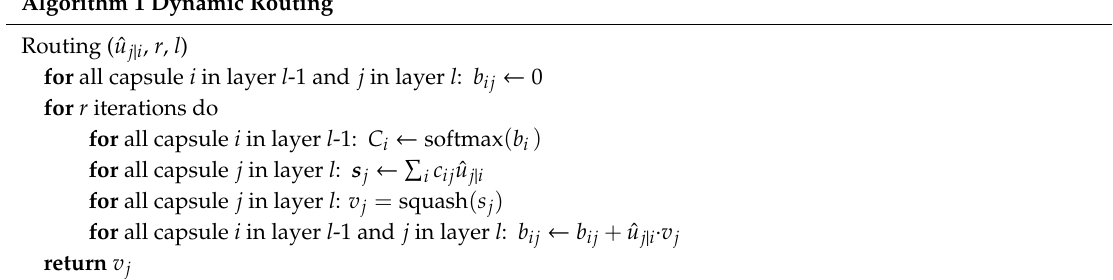
Algorithm 1 Dynamic Routing